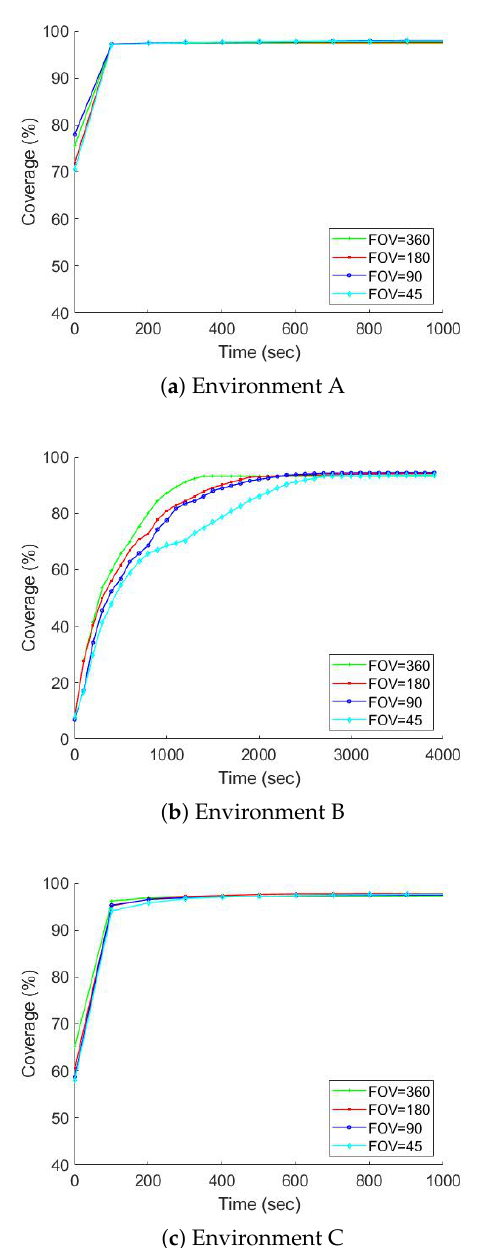
Figure 11. The obstacle map coverage over time based on a set of FOV, AR is equal to 2.5 degrees, average over ten